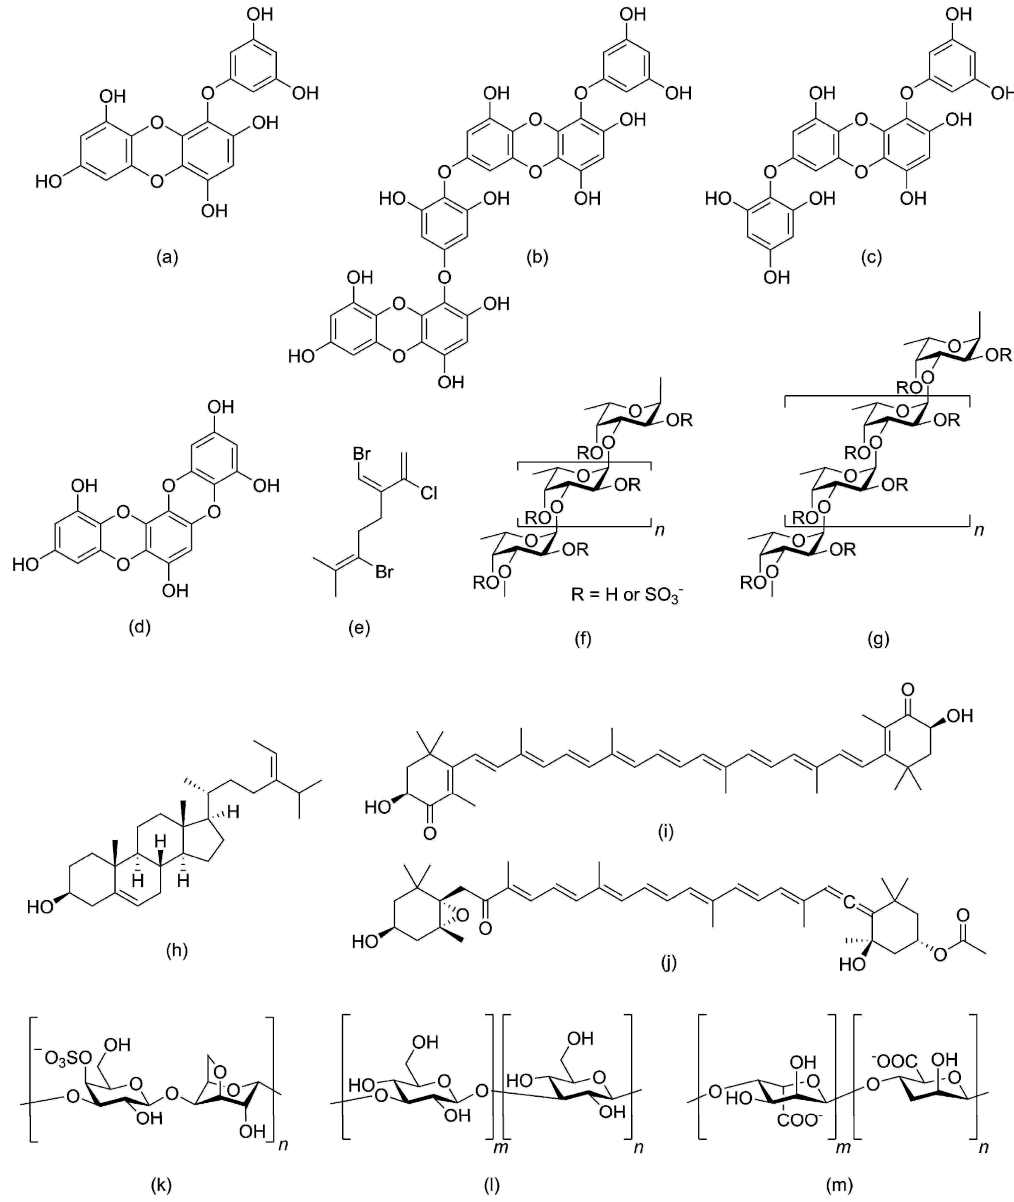
Figure 2. Chemical structure of several algal metabolites that can have beneficial health effects by acting as antioxidants: ( a ) eckol, ( b ) dieckol, ( c ) 7-phloroeckol, and ( d ) dioxinodehydroeckol, four phlorotannins; ( e ) 2-chloro-3-(bromomethylene)-6-bromo-7-methyl-1,6-octadiene, a halogenated monoterpene; ( f ) type I and ( g ) type II fucoidans; ( h ) fucosterol; ( i ) astaxanthin and ( j ) fucoxanthin; ( k ) k-carrageenan; ( l ) laminaran; and ( m ) alginate.